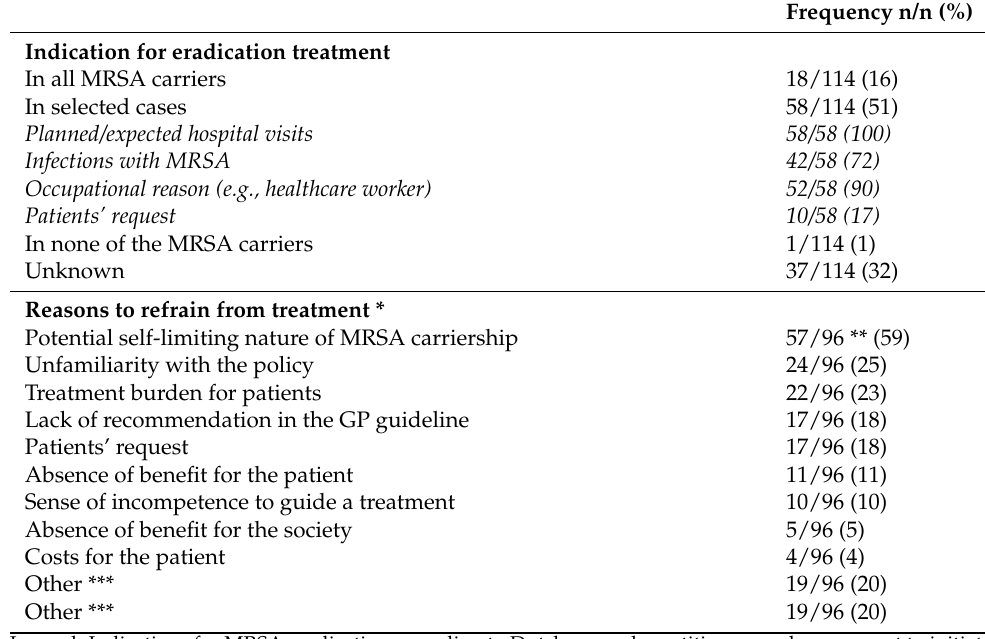
Table 1. The attitude of GPs towards indication for treatment of MRSA